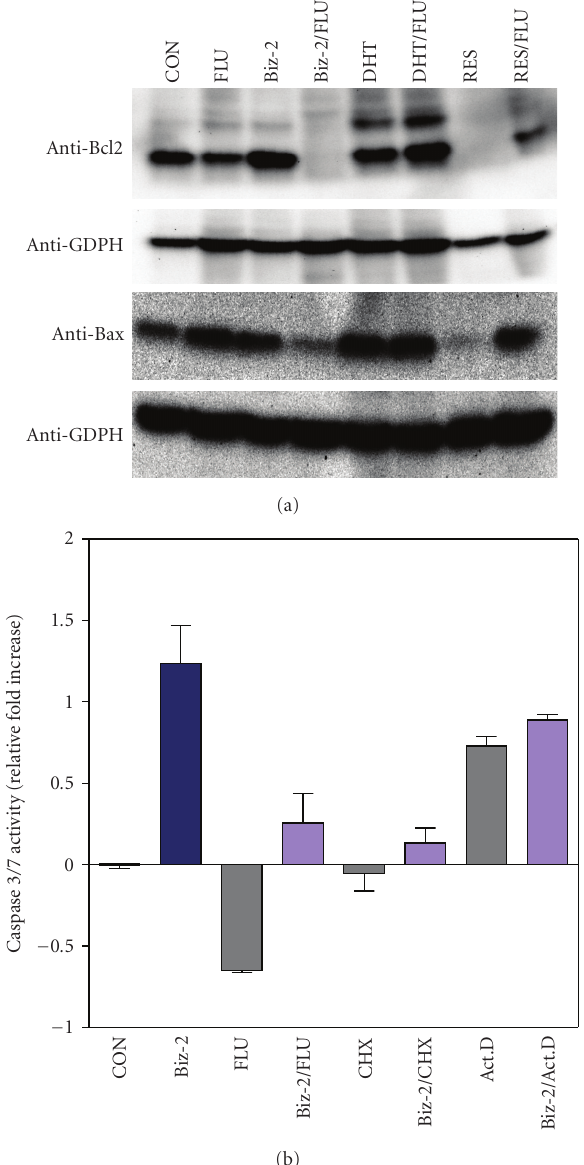
Figure 8: Biz-2 increases Caspase 3/7 levels in LNCaP cells. LNCaP cells (1 × 10 6 ) were grown in test medium and induced with 100ppm Biz-2 for 24 hours, and the resulting Caspase 3/7 activity was determined using the Apo-One Homogeneous Caspase-3/7 assay as described in Section 2. (a) Western blot of Bcl2 and Bax proteins following induction of LNCaP with Biz-2 in the absence and presence of flutamide. (b) Caspase 3/7 activity was expressed as n -fold increase relative to untreated control ( n = 8, mean ±